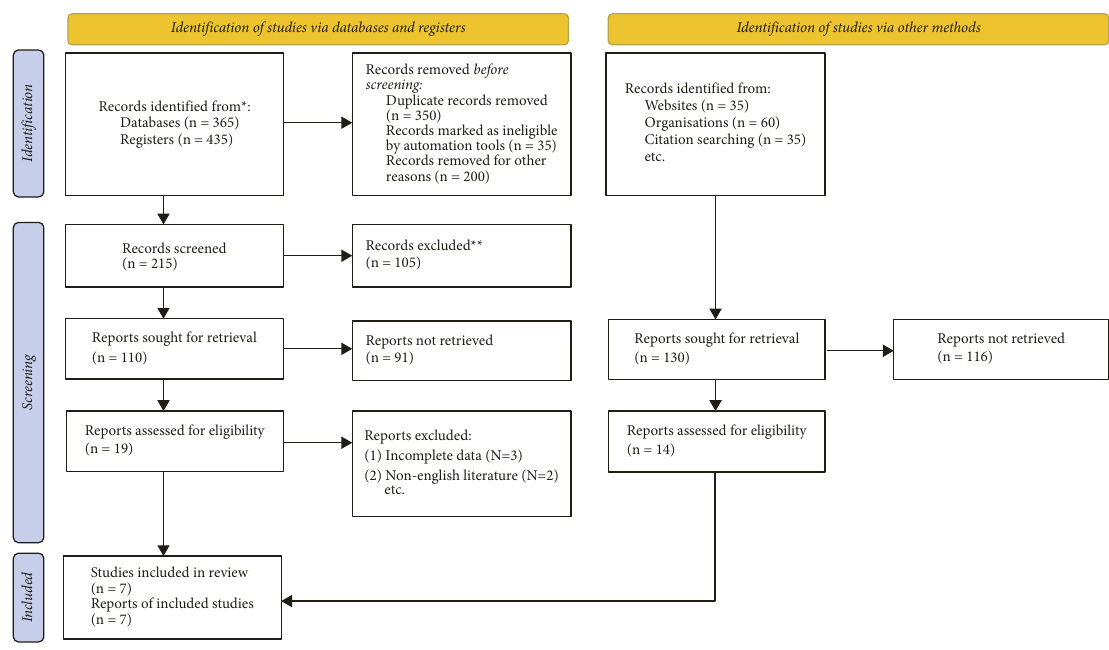
Figure 1: Flow chart of the literature